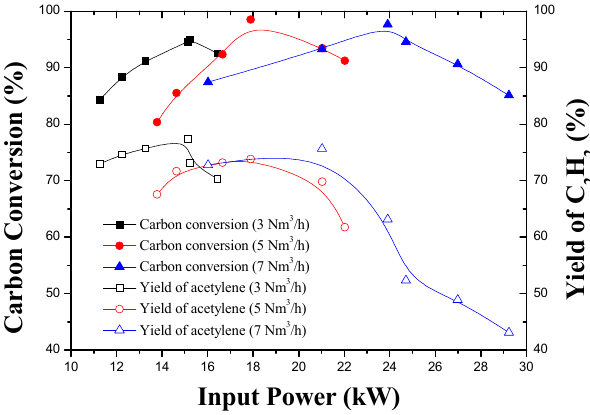
Figure 8. Variation in the carbon conversion and selectivity of C 2 H 2 at working gas flow rate of 3 Nm 3 /h, 5 Nm 3 /h, 7 Nm 3 /h (Carrier gas flow rate: 1 Nm 3 /h; feed rate: 17.65 g/min; magnetic flux intensity: 0.077 T).